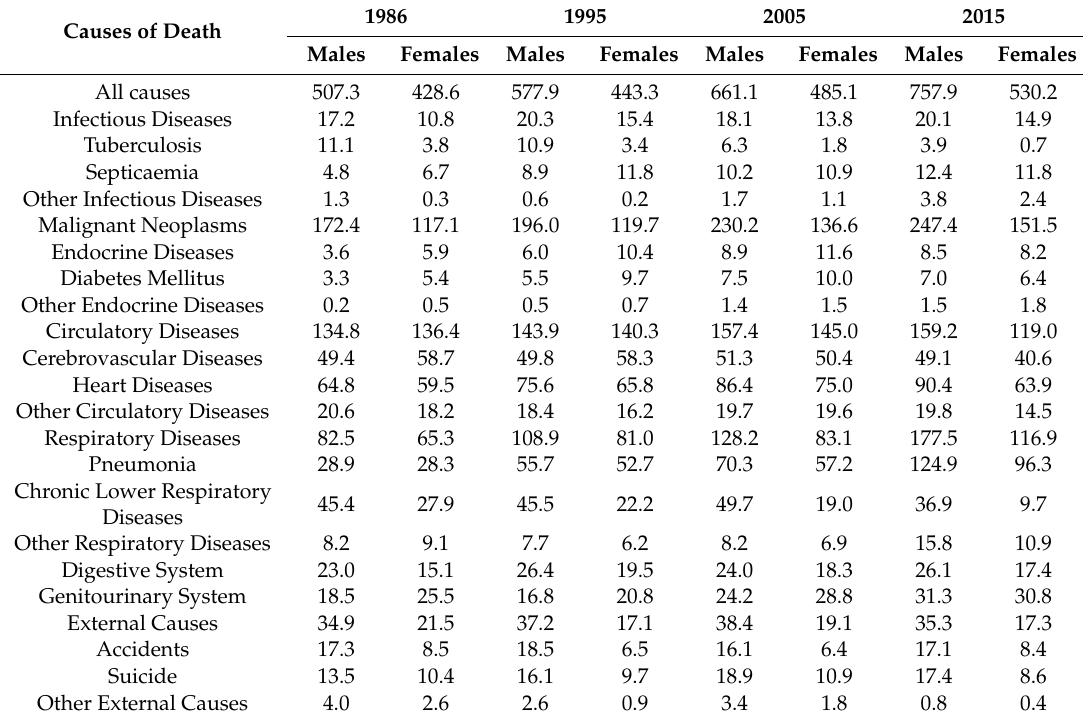
Table 1. Mortality rates for selected causes of death in 1986–2015 in Hong Kong (per